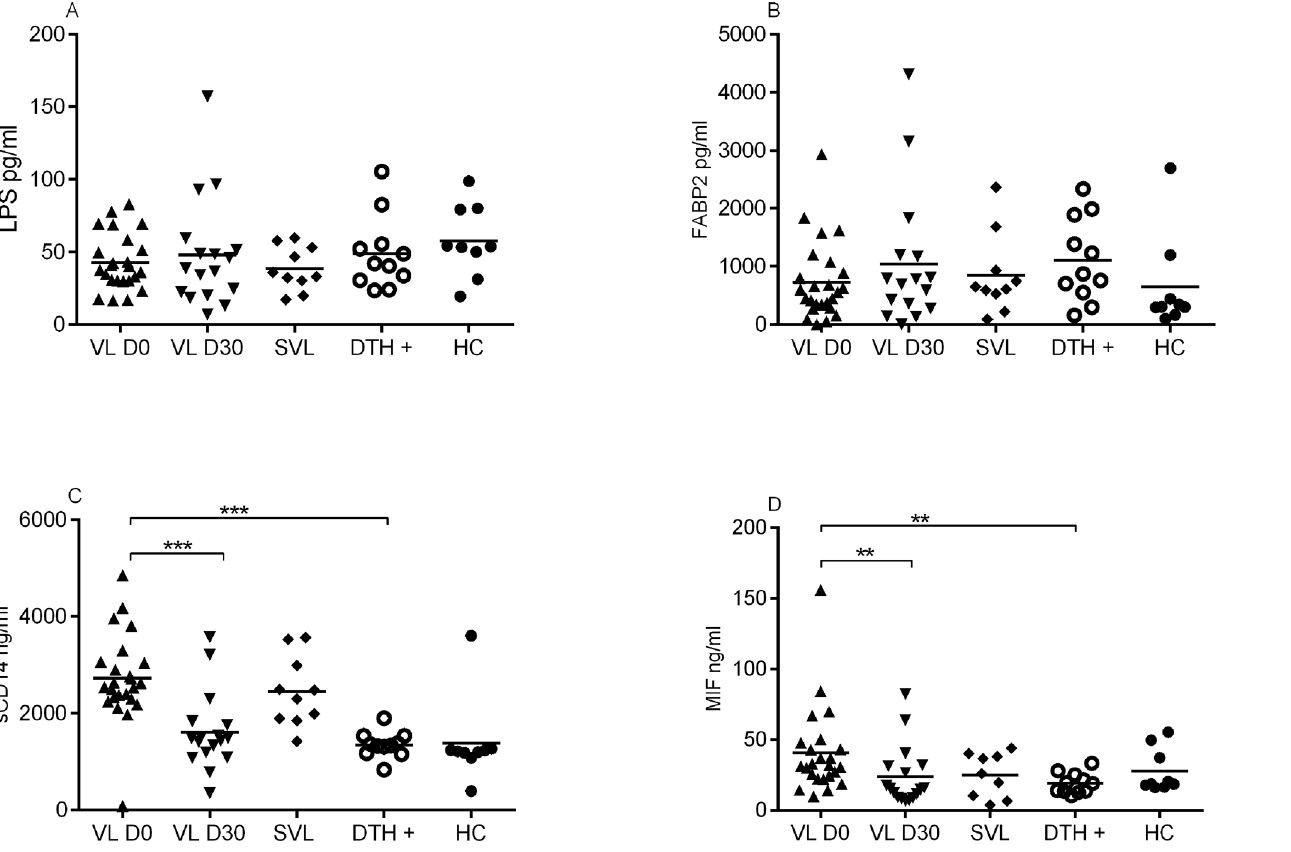
Fig 4. Levels of sCD14 and MIF are elevated in the serum of VL patients. Serum levels of the LPS (A), FABP2 (B), sCD14 (C) and MIF (D) were measured by ELISA in classical VL patients before (n = 25) and after treatment (n = 17) (D0 and D30, respectively), severe VL patients (n = 12), DTH+ (n = 11) and healthy control (n = 07). * Mann-Whitey test.